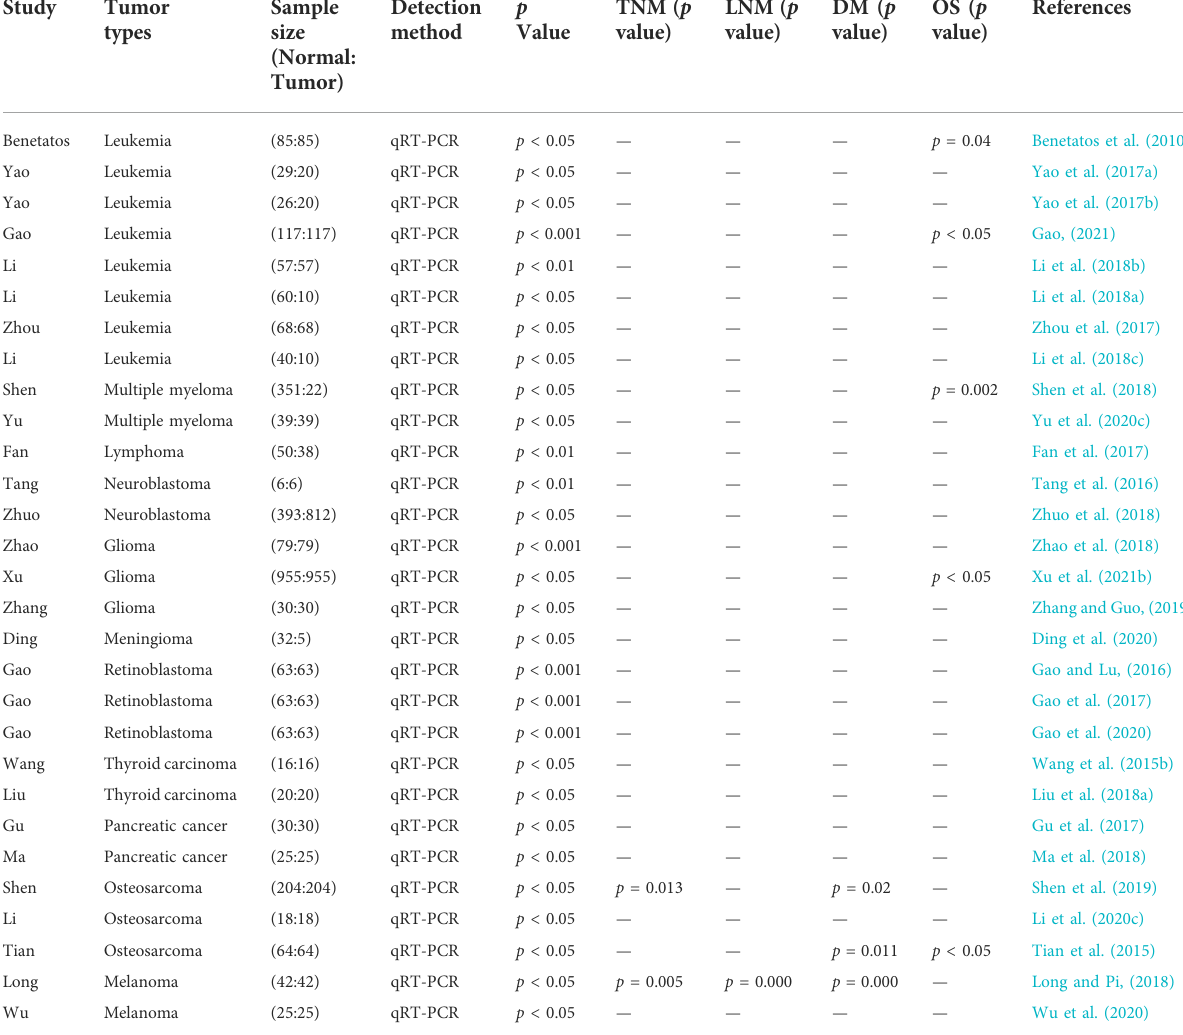
TABLE 6 Features of the studies included in this review of hematological, neuroendocrine, and other system